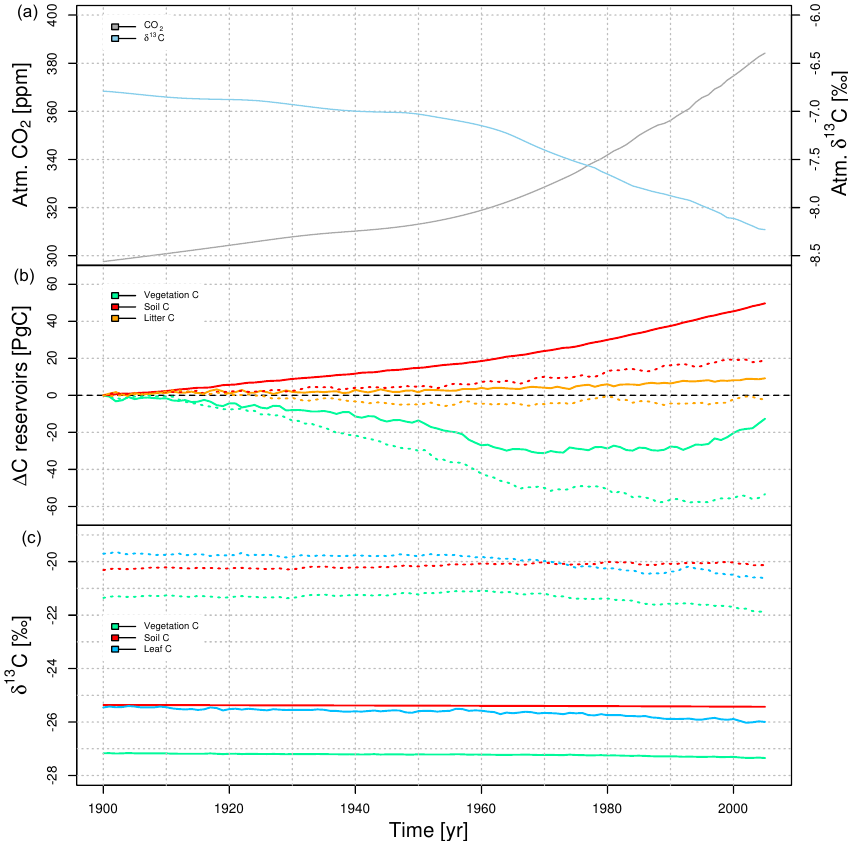
Figure 1. (a) Prescribed evolution of atmospheric CO 2 and its δ 13 C signature, (b) simulated changes in the global inventory of carbon stored in vegetation (green), litter (orange), soils (red), (c) Evolution of the global average (mass-weighted) δ 13 C signature of carbon in leaves, vegetation, and soils (CLM4.5: solid, LPX: